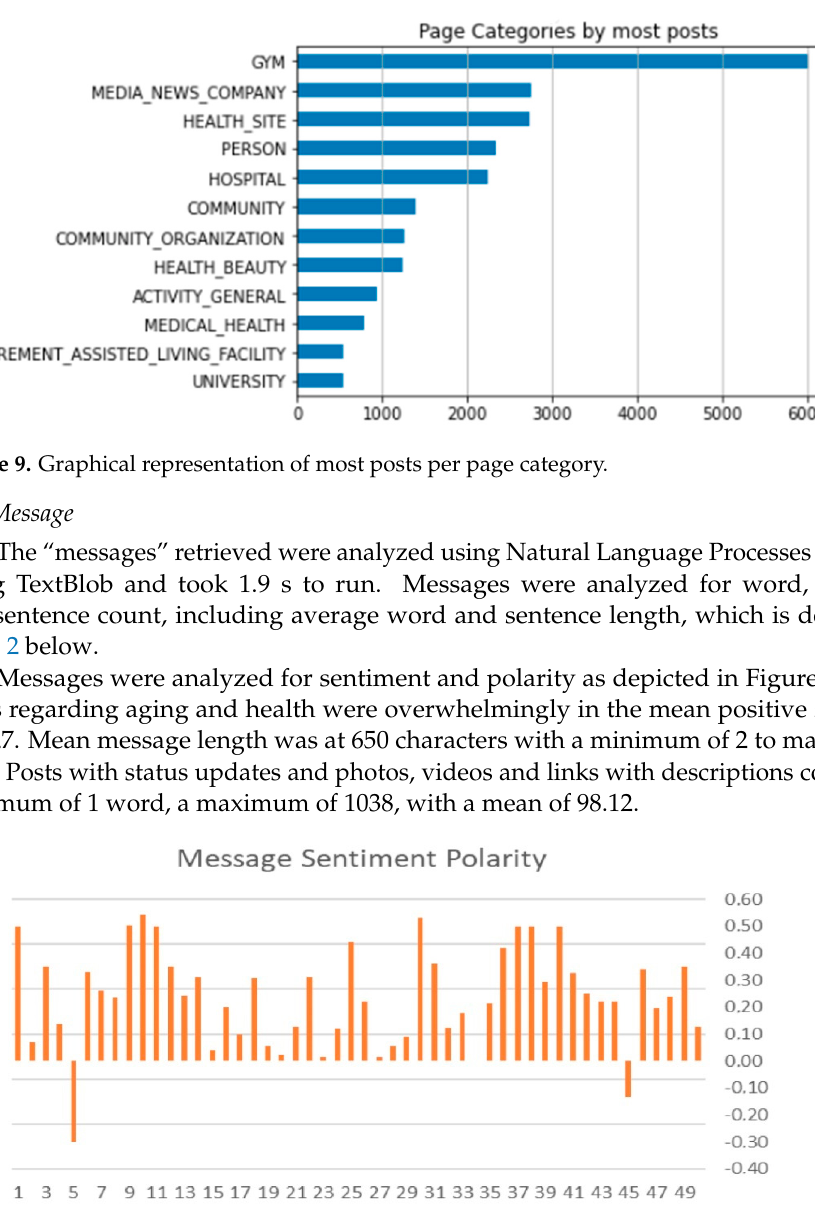
Figure 8. Page names. Word cloud representation of names of Facebook pages and groups.